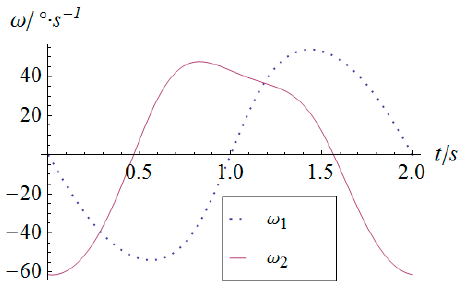
Figure 14. Angular velocity vs. time of the actuators.